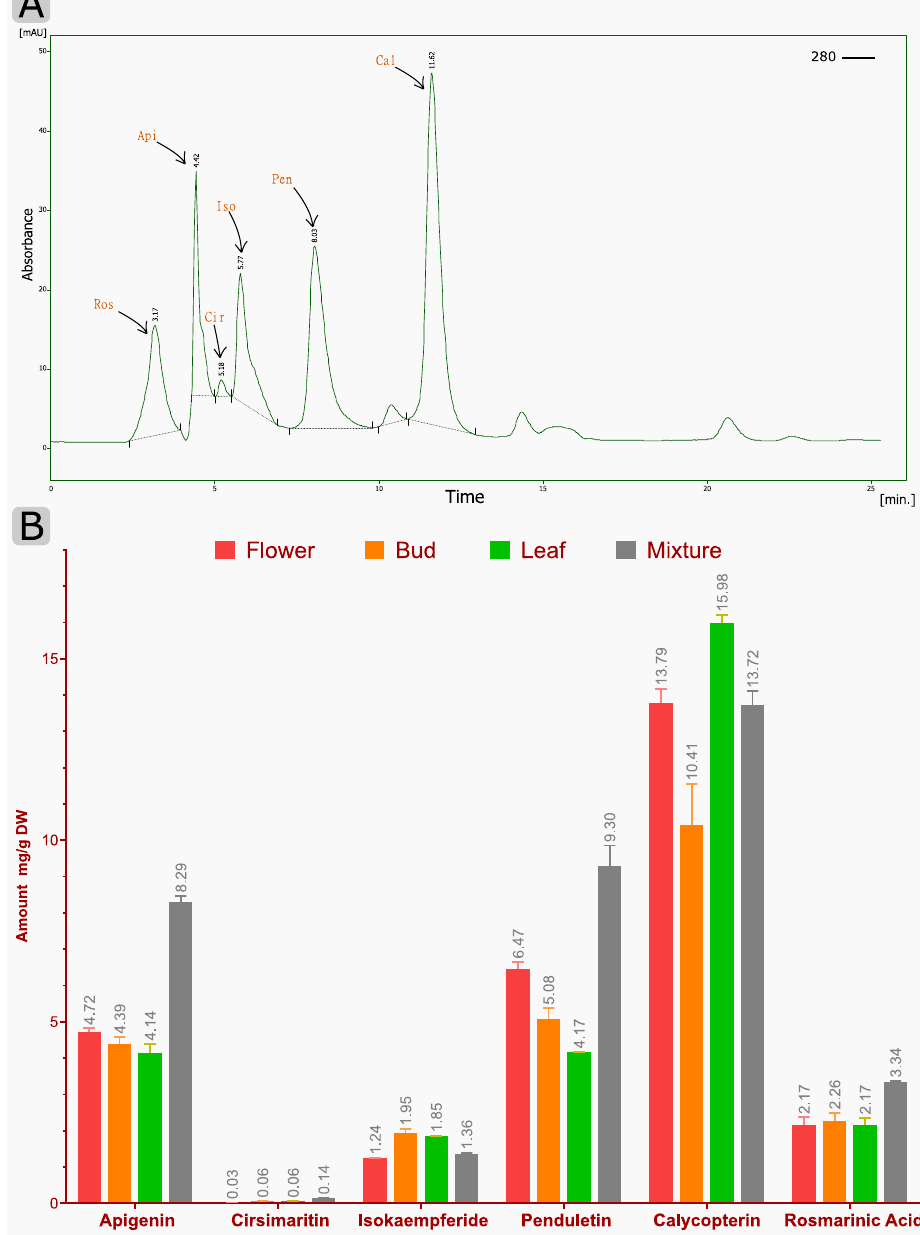
Figure 4. Chromatogram of HPLC peaks and accumulation of flavonoids in different organs of D. kotschyi . ( A ) Chromatograms of HPLC peaks corresponding to: Ros, Rosmarinic acid; Api, Apigenin; Cir, Cirsimaritin; Iso, Isokaempferid; Pen, Penduletin; Cal, Calycopterin in leaf tissue. ( B ) Contents of flavonoids in different organs, including flower, bud, leaf, and a mixture of tissues. The values and error bars represent the mean and standard error of three biological replicates,